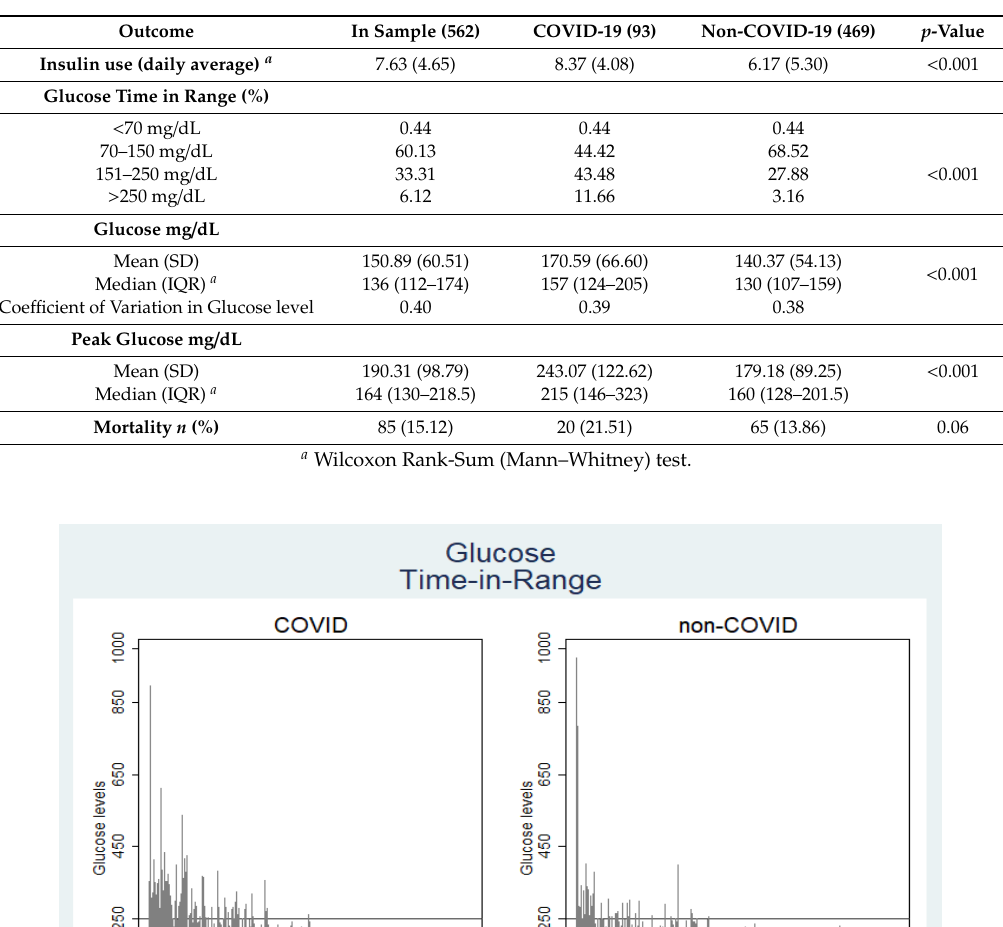
Table 2. Outcomes data.